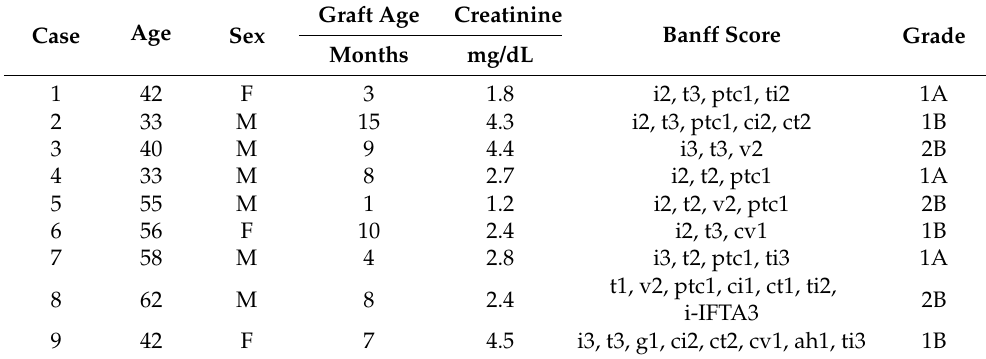
Table 1. Basic data of acute TCMR cases.